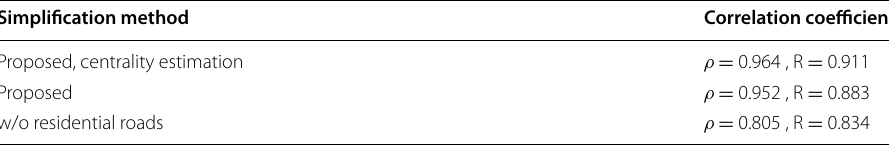
Table 4 Pearson ( ρ ) and Spearman (R) correlation coefficient between centrality measurement of original and simplified networks in